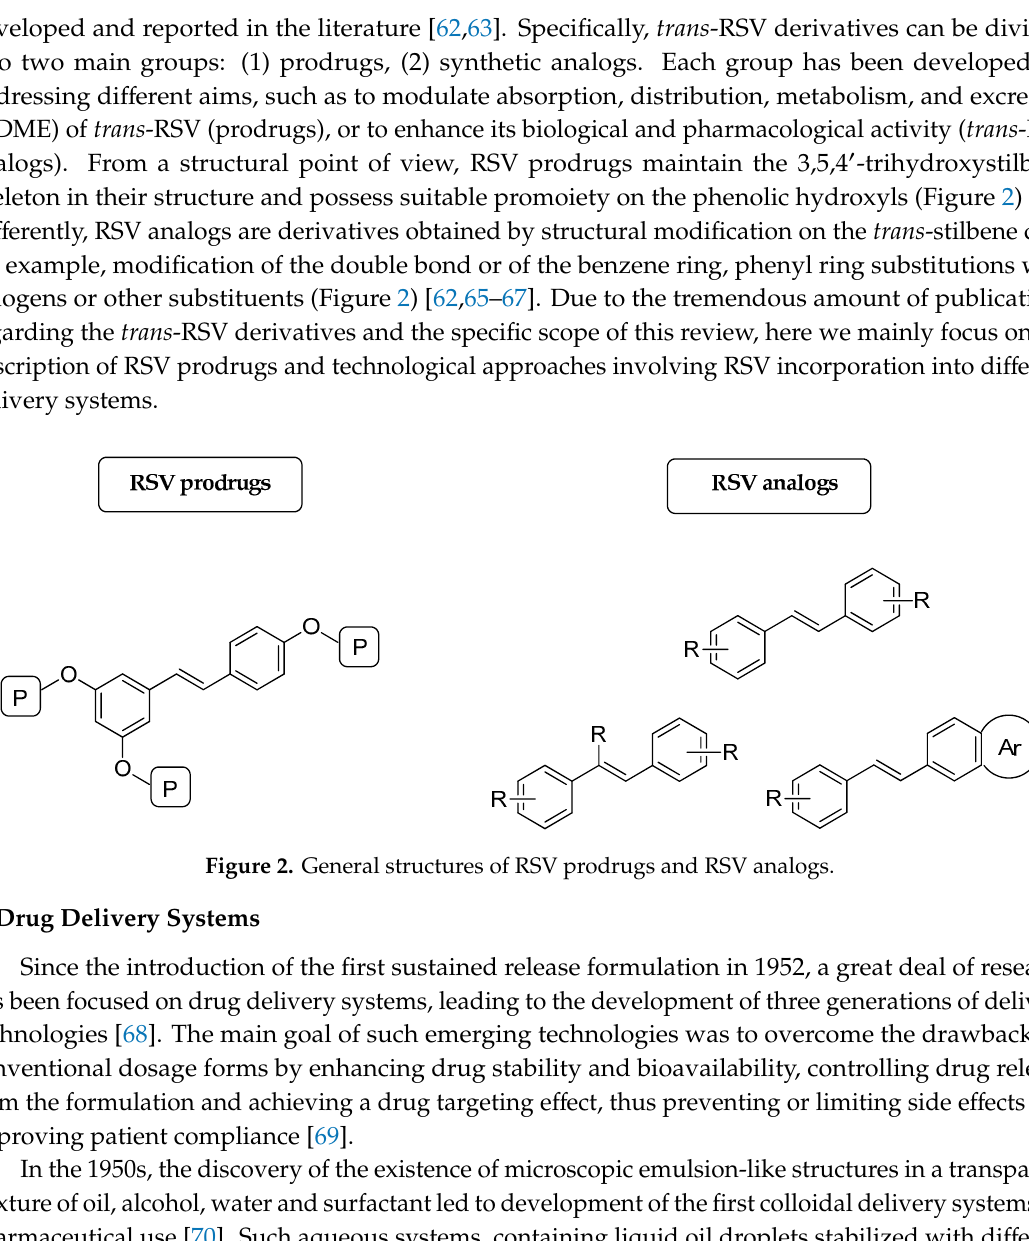
Figure 2. General structures of RSV prodrugs and RSV analogs.